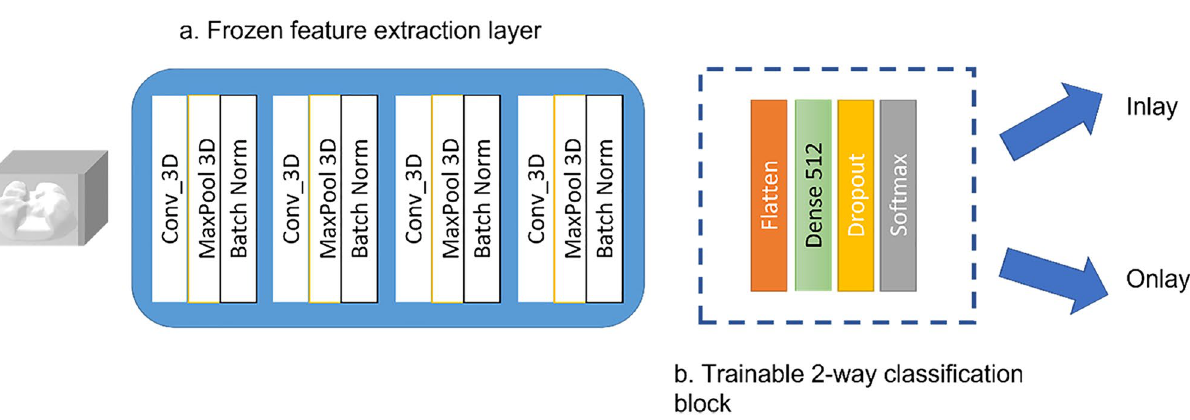
Figure 3. The 3D neural